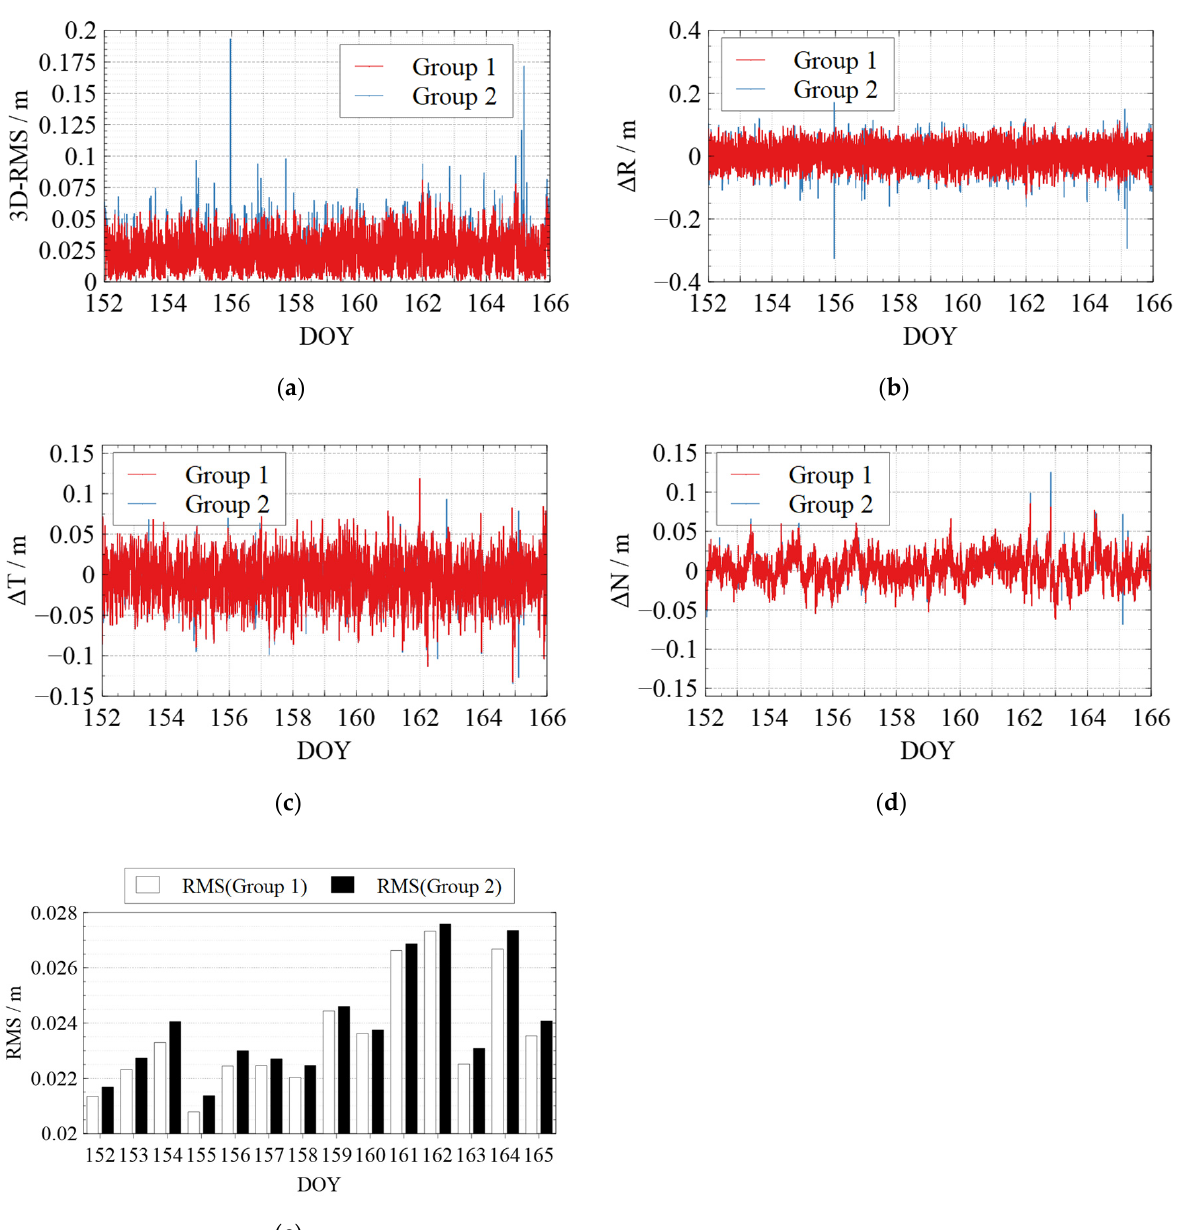
Figure 9. Comparison between the kinematic orbits of GRACE-C and the precise orbits provided by the GFZ. ( a ) 3D-RMS of the comparison results; ( b ) Difference in Radial direction; ( c ) Difference in Tangent direction; ( d ) Difference in Normal direction; ( e ) Average 3D-RMS statistics of the comparison results. Where the red line shows the results of Group 1 while the blue line shows the results of Group 2 in ( a – d ). The white blocks and black blocks in ( e ) represent the RMS of Group 1 and Group 2 on each day, respectively.